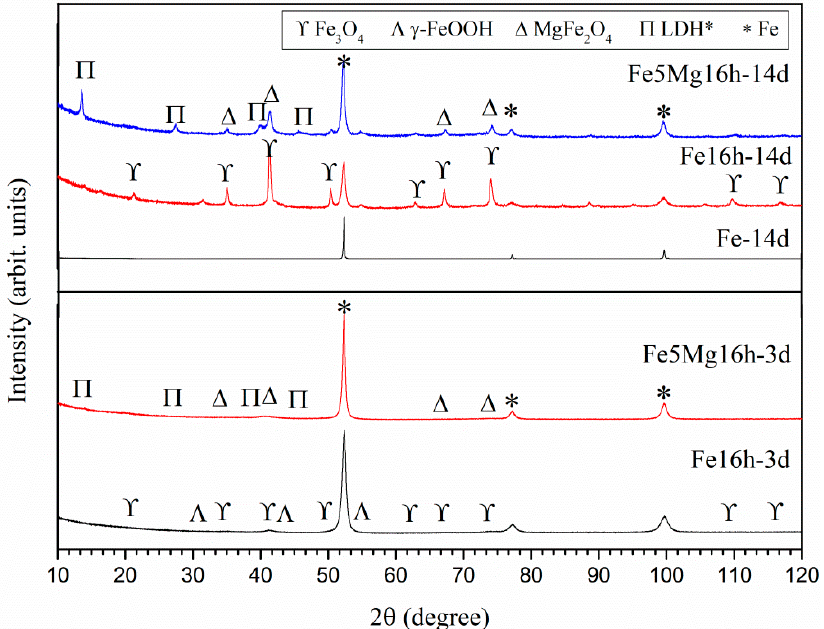
Figure 5. XRD of the degraded powders after 3 days (Fe5Mg16h and Fe16h-3d), and 14 days (Fe5Mg16h-14d, Fe16h-14d, and Fe-14d) of immersion in Hanks’ solution. Arbitrary units. LDH*: Mg 0.75 Fe 0.25 [OH] 2 [CO 3 ] 0.125 ·0.5[H 2